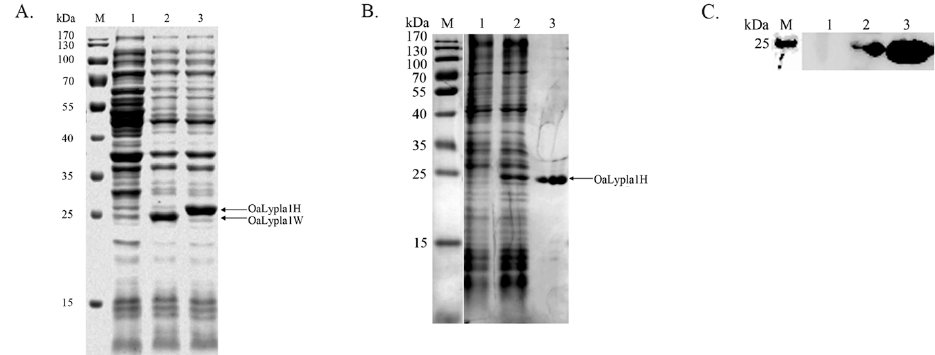
lane 1 : total proteins from the uninduced pET-30a-LYPLA1-W cells; lane 2 : total proteins from the